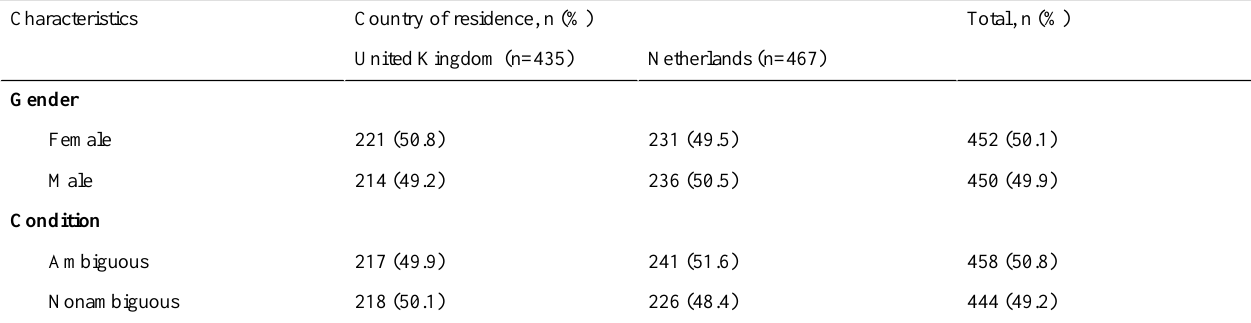
Table 1. Study sample characteristics (n=902).